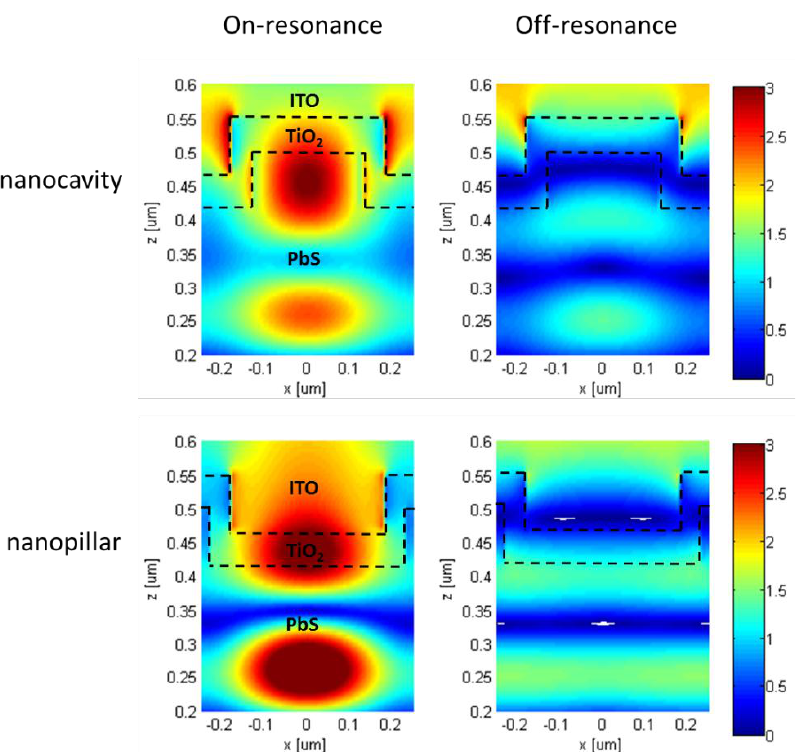
Figure 5. Simulated electric field distributions inside the PbS QDs layer with patterned structures. The hot spots present at resonance wavelengths (950 nm for both structures) with high field intensity indicate strong absorption inside PbS CQD. No hot spots are observed at off resonance wavelengths (1000 nm for both structures) suggesting the importance of resonant coupling of the incident into CQD layer for significant absorption enhancement.